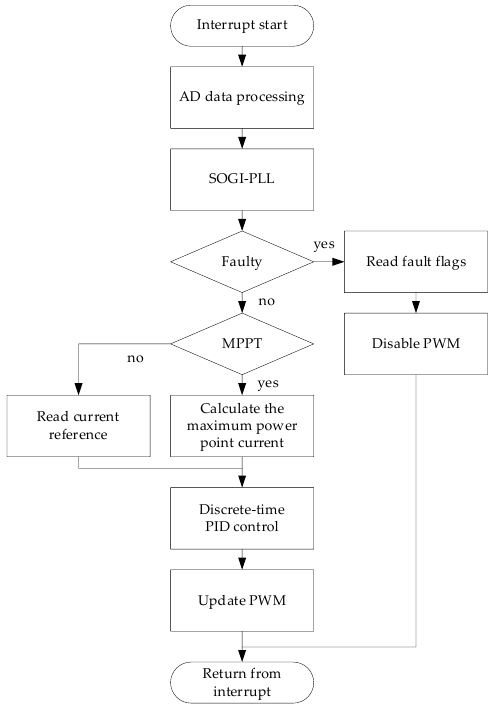
Figure 10. Control program flowchart.